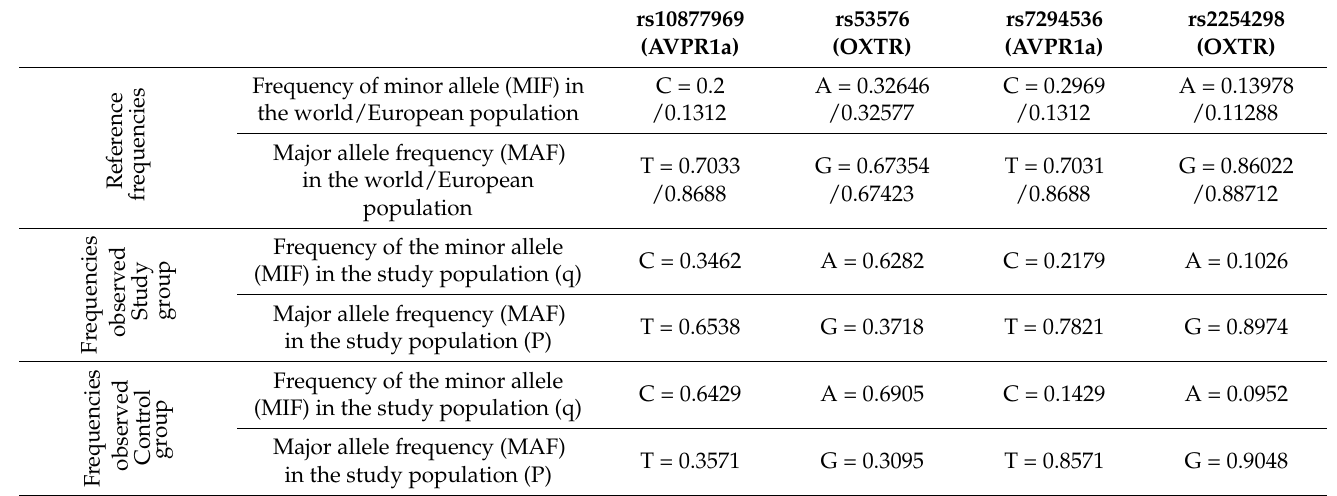
Table 1. Distribution and frequency of alleles of selected polymorphisms in the test and control groups in relation to the reference frequency based on the 1000Genomes database